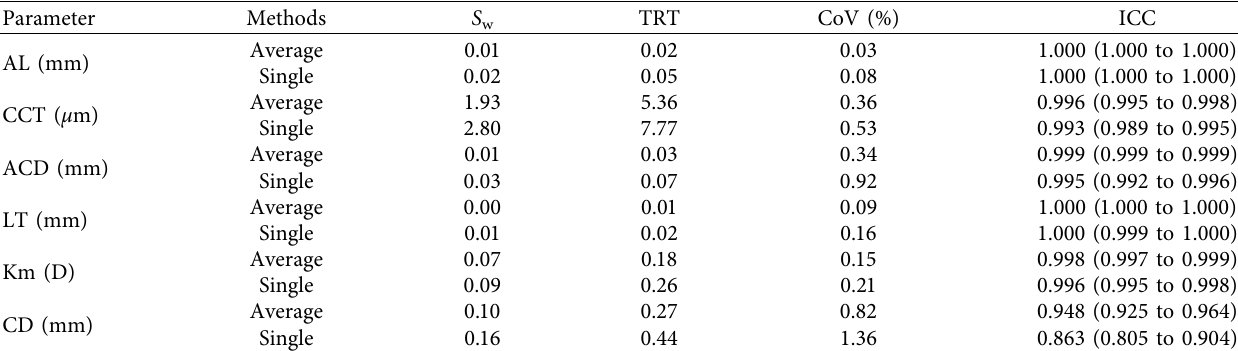
Table 6: Interobserver reproducibility outcomes for biometric measurements obtained using an IOLMaster 700 swept-source optical coherence tomography-based biometer in cataract